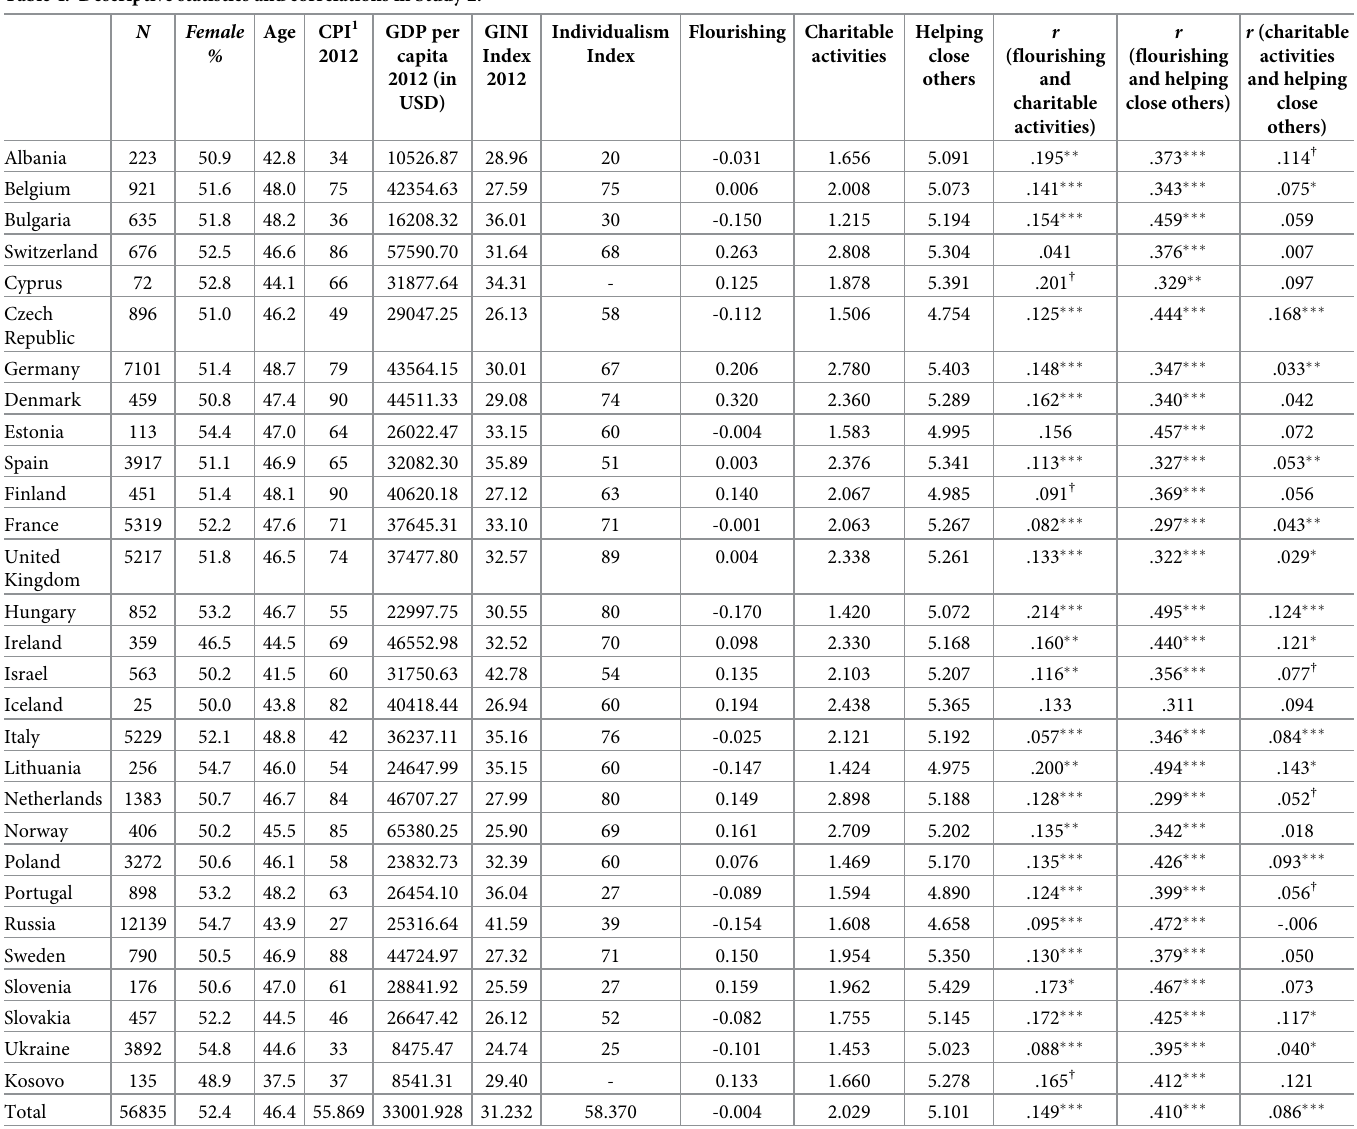
Table 4. Descriptive statistics and correlations in Study